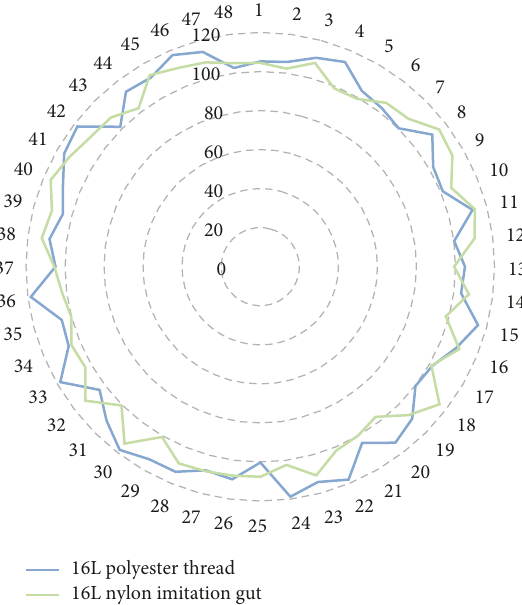
Figure 4: The speed of different material groups.